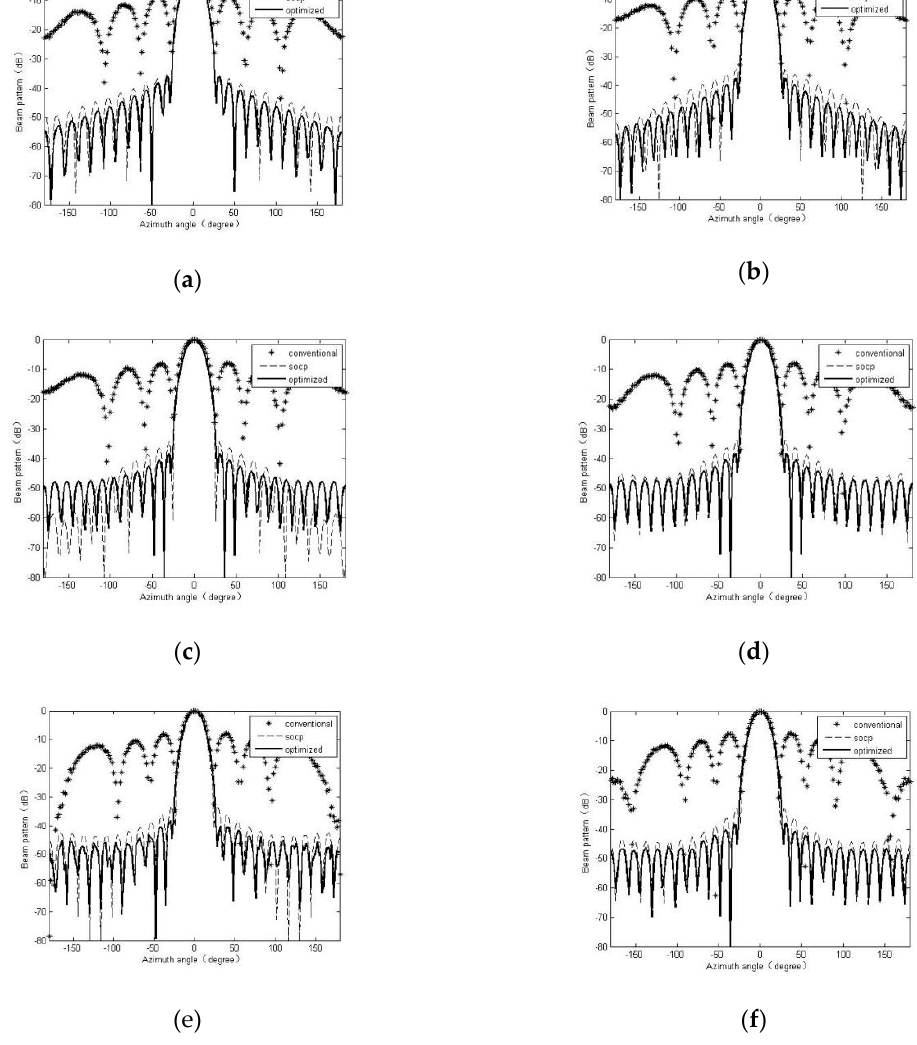
Figure 10. Beam pattern of measured array manifold at six frequency points. ( a ) Comparison of beam pattern at 2250 Hz; ( b ) comparison of beam pattern at 2400 Hz; ( c ) comparison of beam pattern at 2550 Hz; ( d ) comparison of beam pattern at 2700 Hz; ( e ) comparison of beam pattern at 2850 Hz; ( f ) comparison of beam pattern at 3000 Hz.